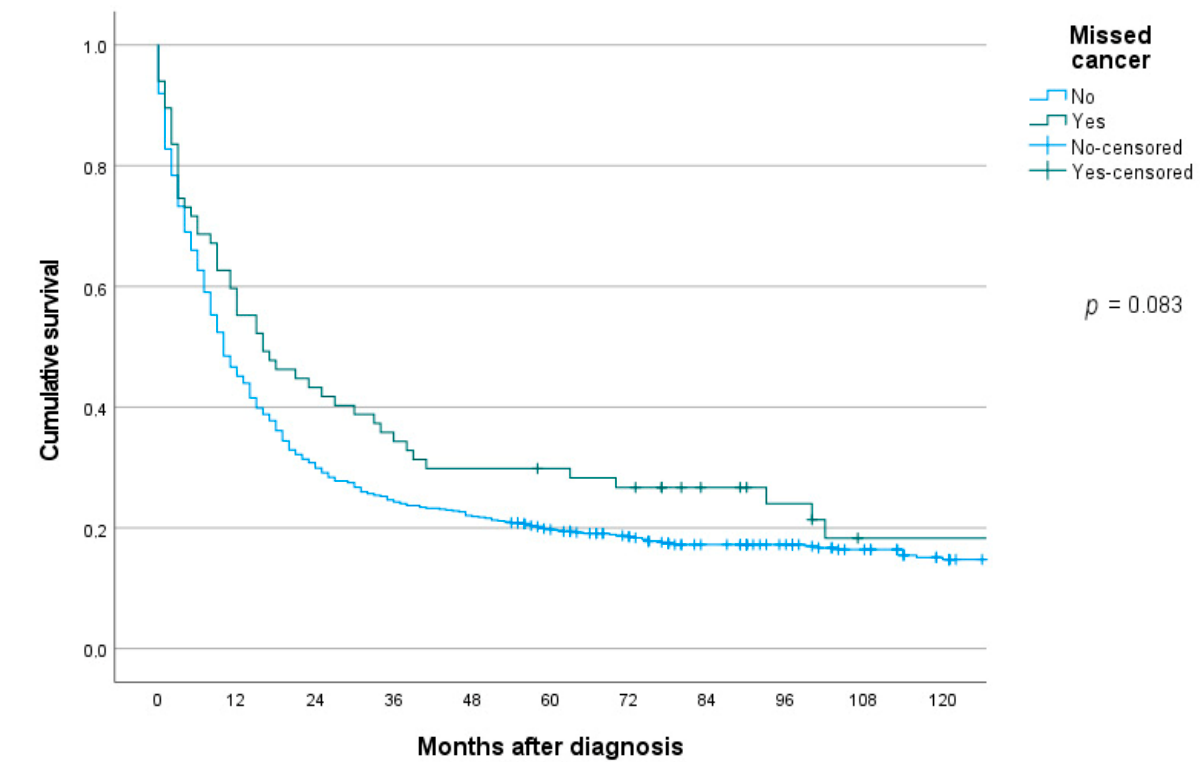
Figure 2. Long-term overall survival in patients with gastric cancer missed at upper endoscopy or not.